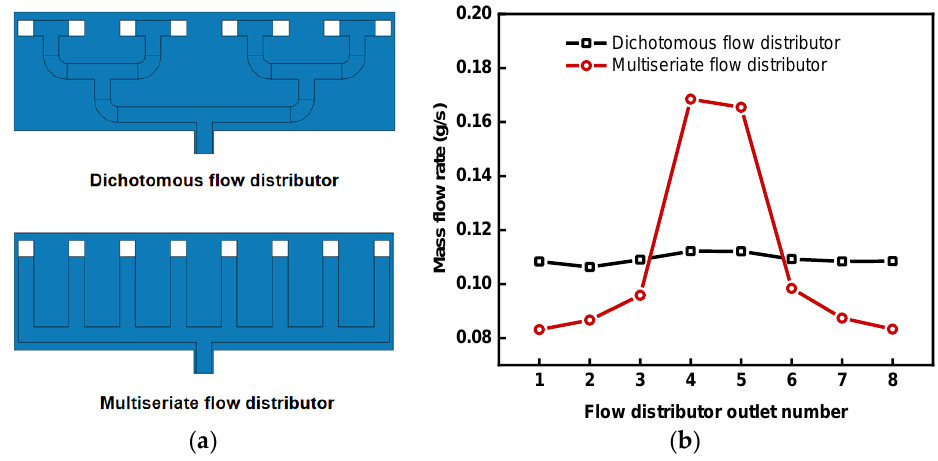
Figure 4. Comparison of flow uniformity capacity of the dichotomous and multiseriate flow distrib- utors. ( a ) The channel structure of the dichotomous and the multiseriate flow distributors; ( b ) the mass flow rate of each outlet face of these two flow distributors.